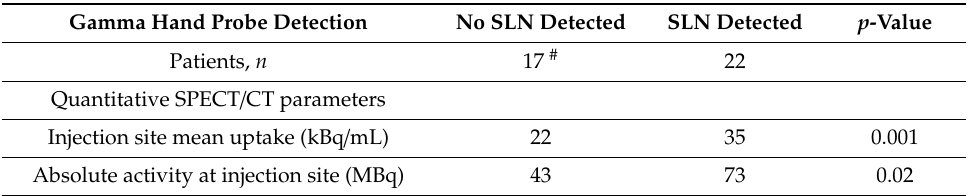
Table 3. SPECT / CT derived quantitative parameters significantly a ff ecting intra-operative SLN detection using gamma hand